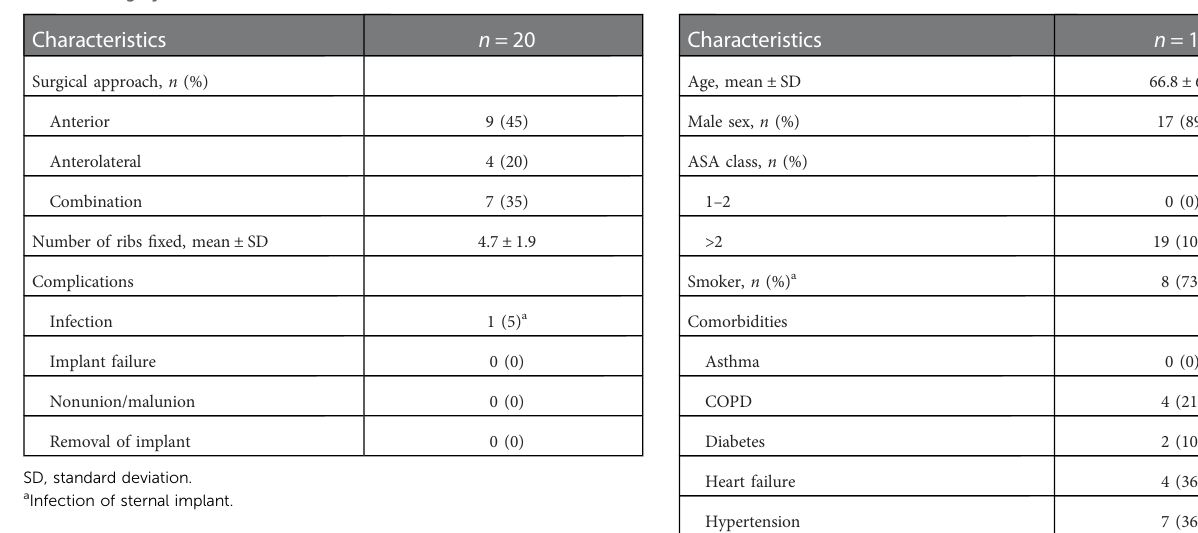
TABLE 2 Baseline characteristics. TABLE 1 Surgery